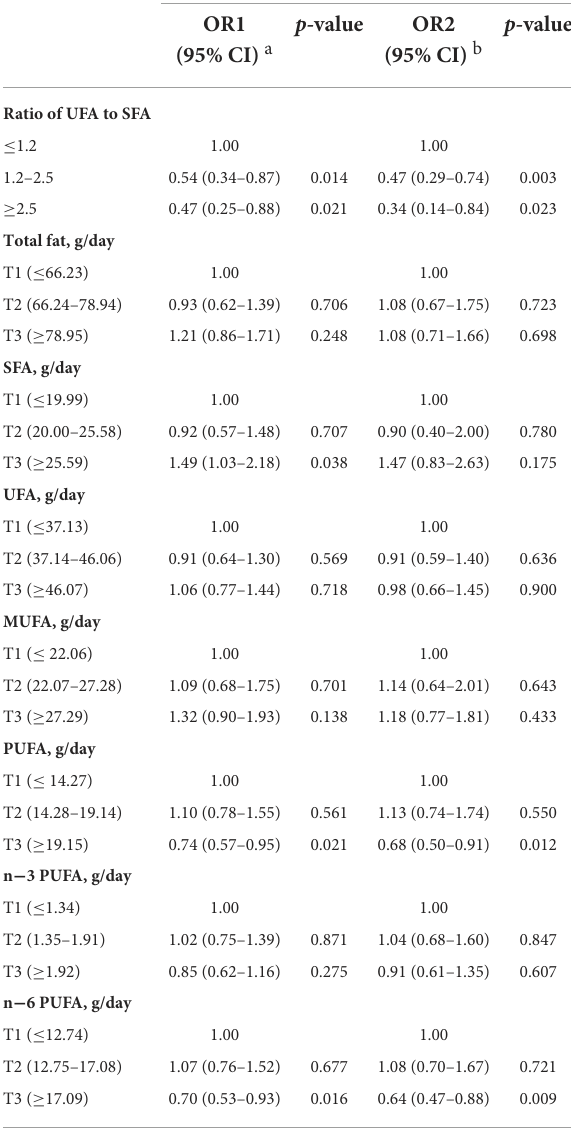
TABLE 2 Multivariate logistic regression model considering dietary fatty acid intakes and the risk of significant liver fibrosis in participants, NHANES 2017–2018 ( n =